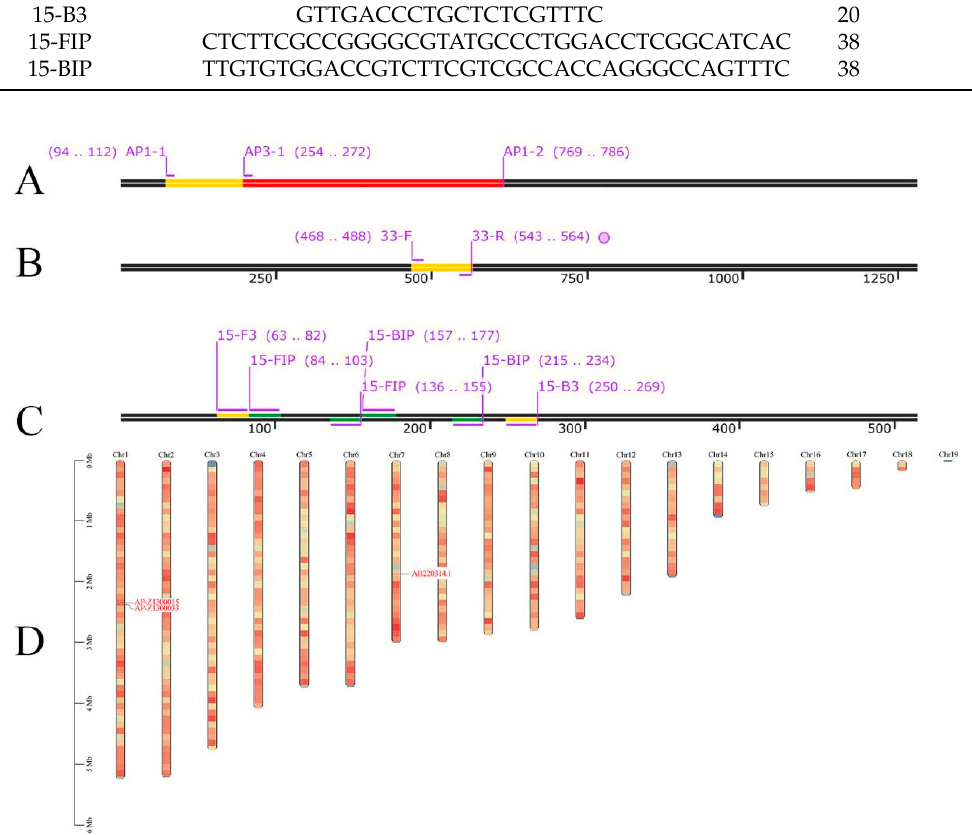
Figure 1. Schematic of primer design. ( A ) Seminested PCR: AP1-1, AP1-2, and AP3-1 binding sites; ( B ) qPCR: 33-F/33-R binding sites; ( C ) LAMP: two external (15-F3 and 15-B3) and two internal (15-FIP and 15-BIP) primer binding sites; ( D ) chromosomal location of AP-Z1300015, AP-Z1300033, and AB220314.1 in A. phaeospermum .